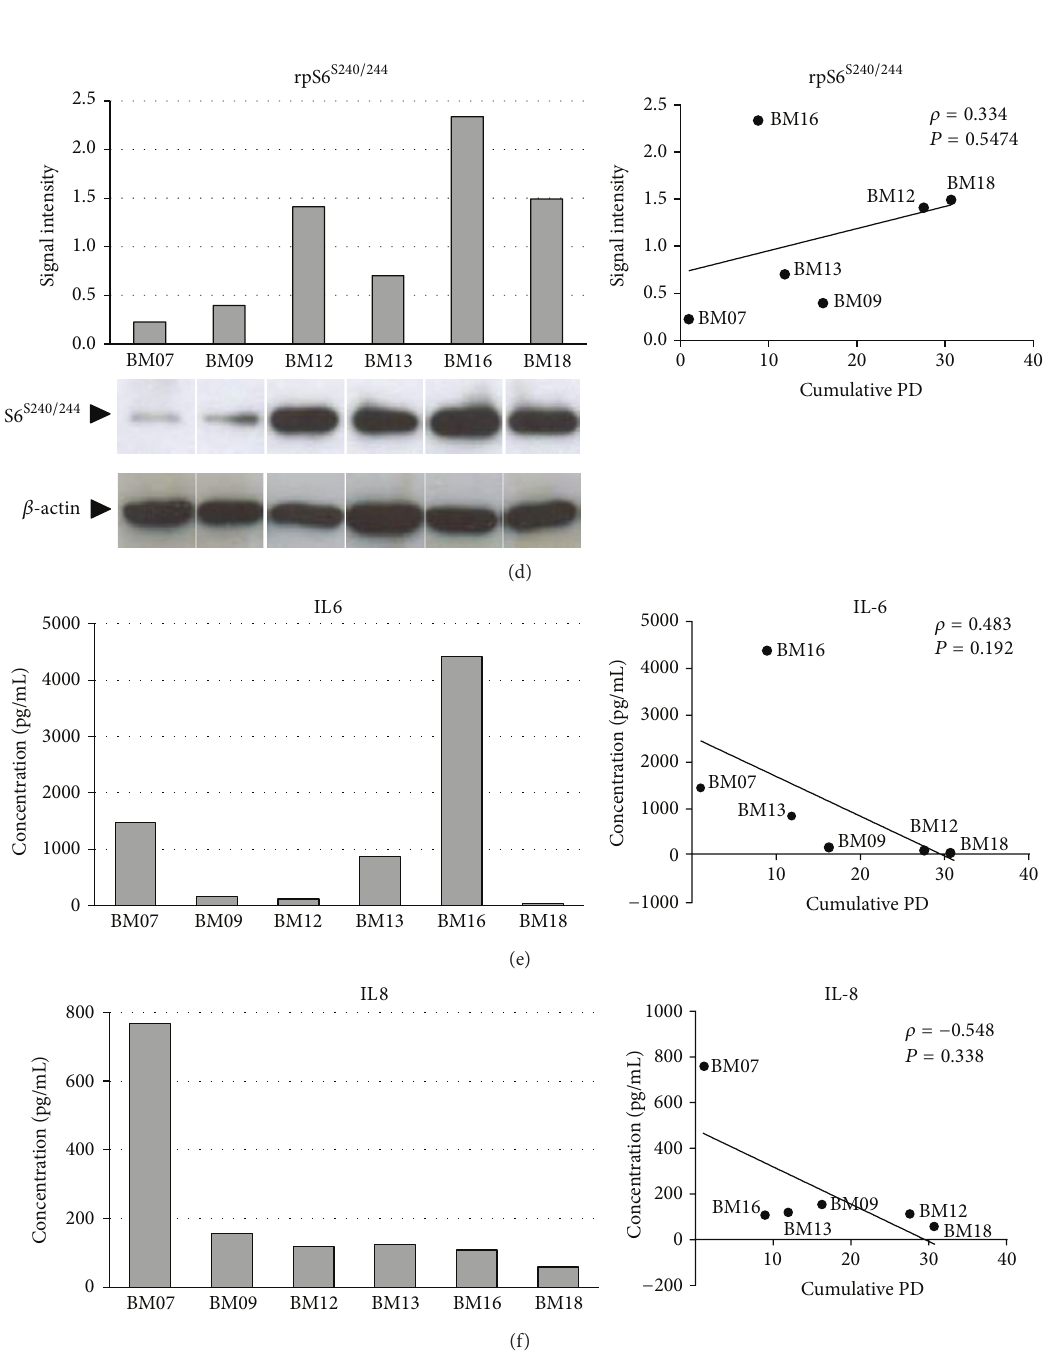
Figure 3: Low p16 INK4A protein expression as a robust early marker of BM-MSC lifespan. The protein expression levels of (a) p16 INK4A , (b) p21 WAF1 , (c) SOD2, and (d) rpS6 S240 / 244 in early passage cells from each donor were analyzed by western blot. Band intensities were densitometrically evaluated and bar graphs on the left represent the densitometric values of p16 INK4A , p21 WAF1 , SOD2, and rpS6 S240 / 244 normalized to the loading control ( 𝛽 -actin). Normalized expression values were then plotted against the final PD number and statistically analyzed by Spearman correlation, as shown in the graphs on the right. The expression levels of p16 INK4A protein in early passage cells were inversely correlated with lifespan. Results are representative of three independent experiments, with similar